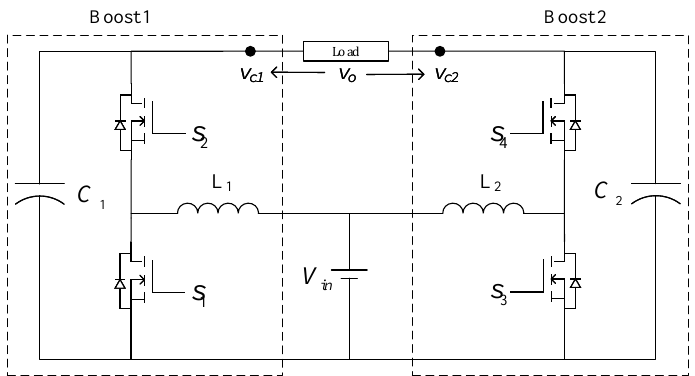
Figure 1. A DC-AC boost